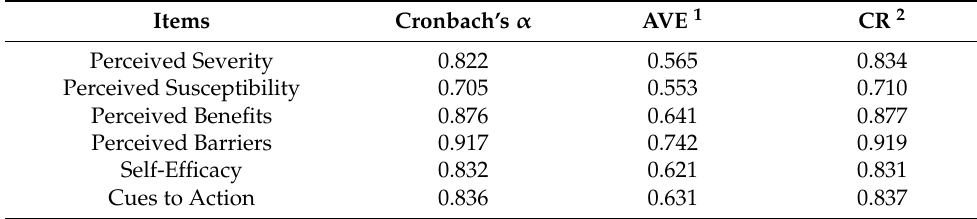
Table 4. Reliability and validity of HBM measures.